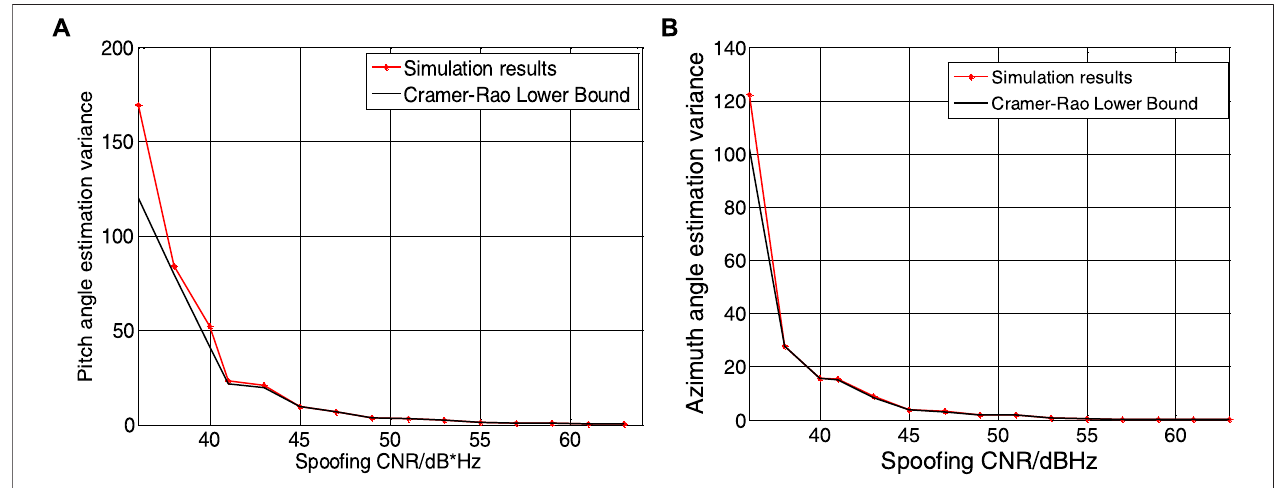
FIGURE 6 | Angle of arriver estimation error. Result of pitch angle is shown in fi gure (A) , and result of. azimuth angle is shown in fi gure (B) .